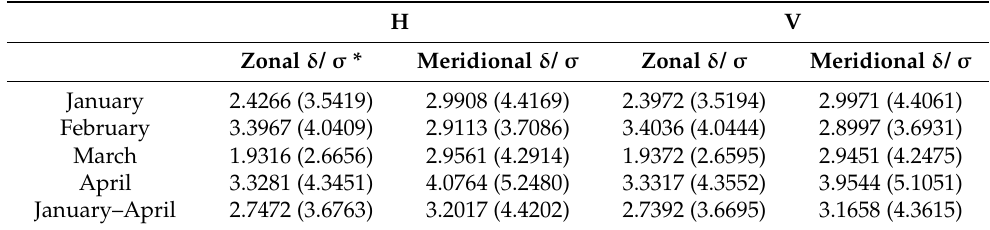
Figure 4. Schematic diagram of the movement of sea ice retrieved by FY ‐ 3D/MWRI T b data at 89 GHz. Figure ( a )–( d ) show sea ice motion retrieved from FY ‐ 3D/MWRI T b data at 89 GHz with V polarization. Figure ( e )–( h ) show sea ice motion retrieved from FY ‐ 3D/MWRI T b data at 89 GHz with H polarization.